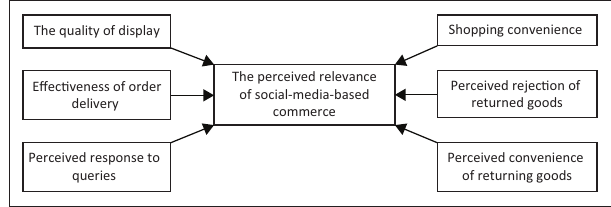
FIGURE 2: Factors determining the perceived relevance of social media commerce.